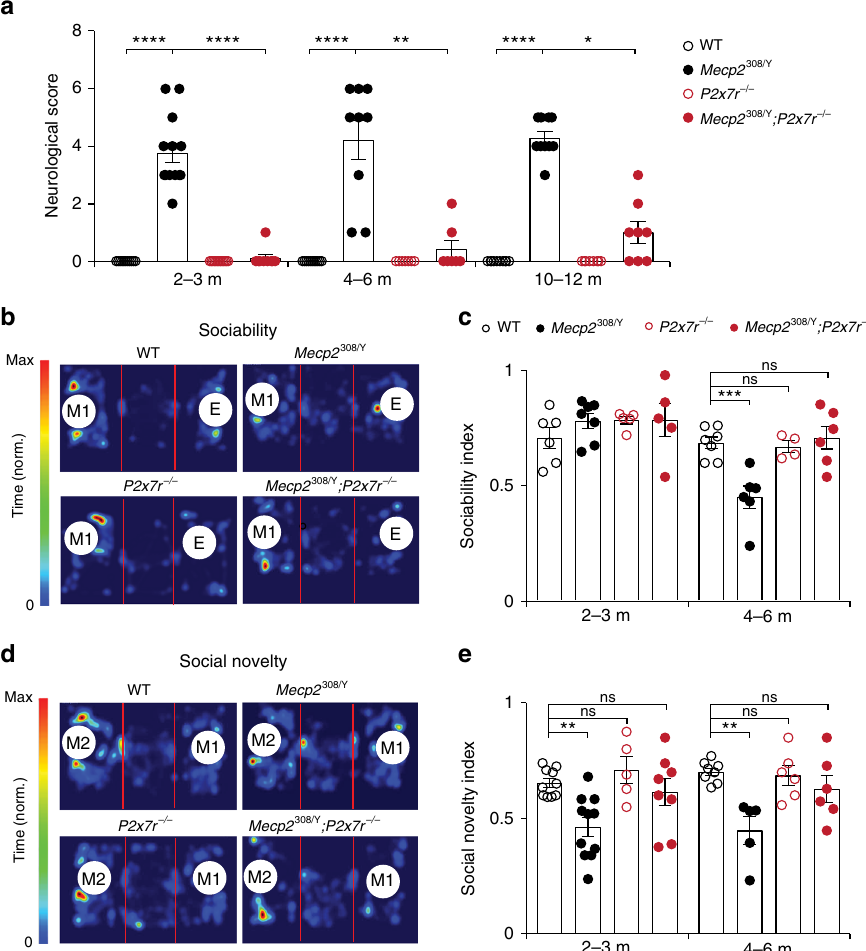
Fig. 4 P2X7R knockout ameliorates behavioral de fi cits in Mecp2 308/Y mice. a Assessments of neurological function in WT, Mecp2 308/Y , P2x7r − / − and Mecp2